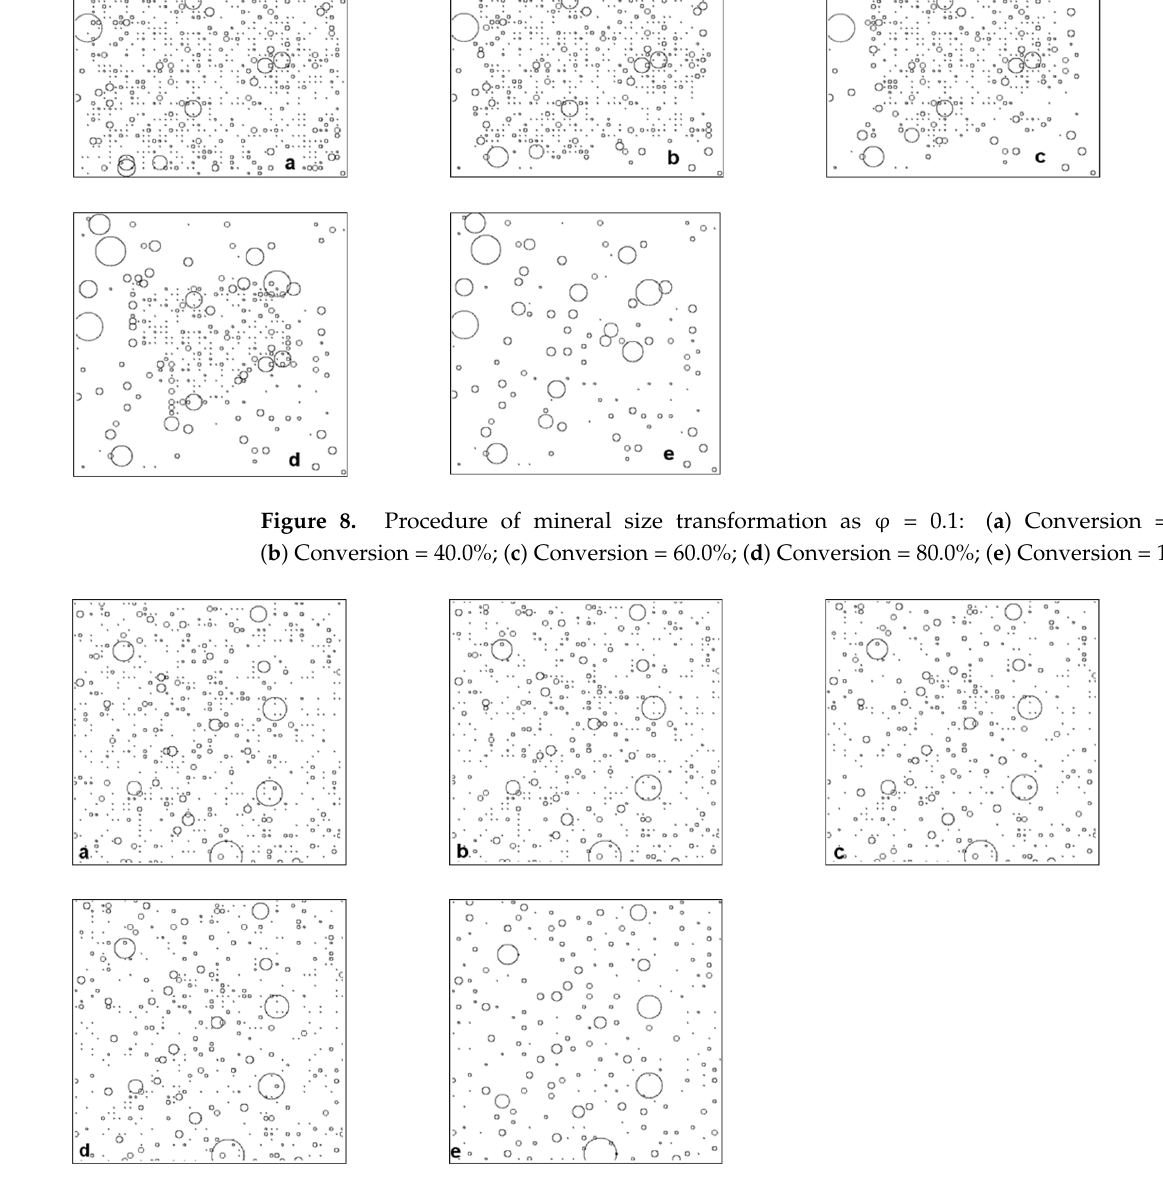
Figure 9. Procedure of mineral size transformation as φ = 0.4: ( a ) Conversion = 20.0%; ( b ) Conversion = 40.0%; ( c ) Conversion = 60.0%; ( d ) Conversion = 80.0%; ( e ) Conversion = 100%.